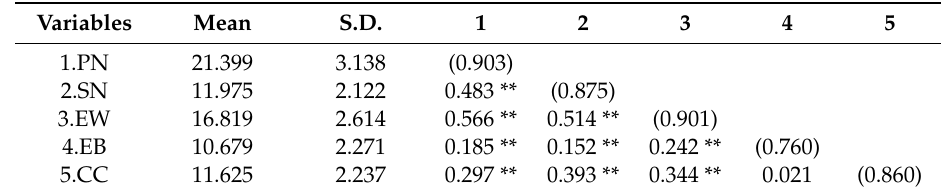
Table 2. Pearson correlation coe ffi cient and average variance extraction amount (AVE) square root value of each